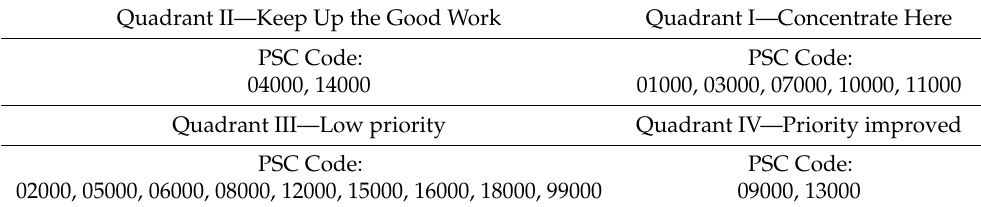
Table 8. F-IPA collation table.